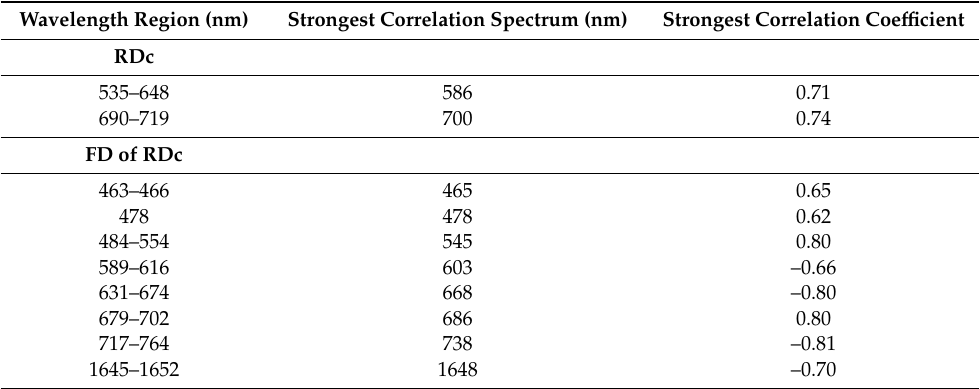
Table 4. Correlation coe ffi cient ( r ) matrix between As content and spectral parameters of red absorption derived from continuum-removed spectra.